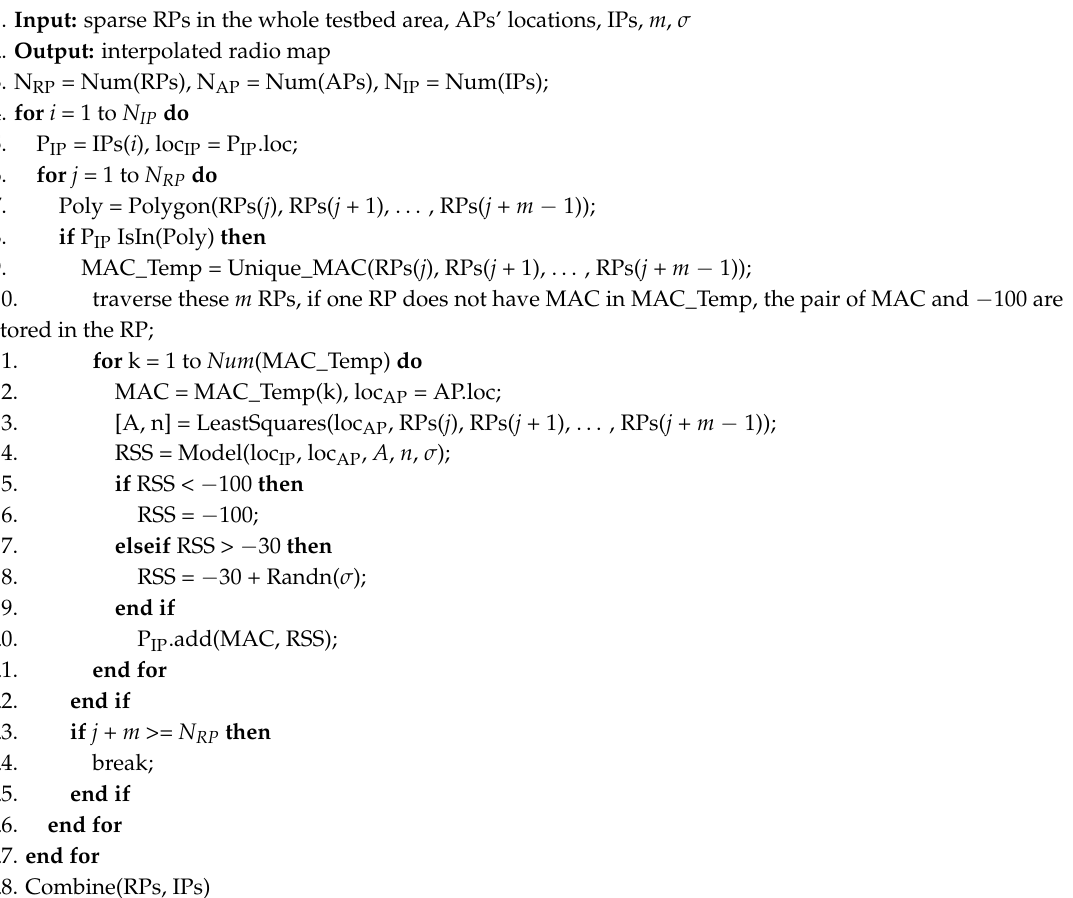
Algorithm 1. Radio map construction based on adaptive path loss model